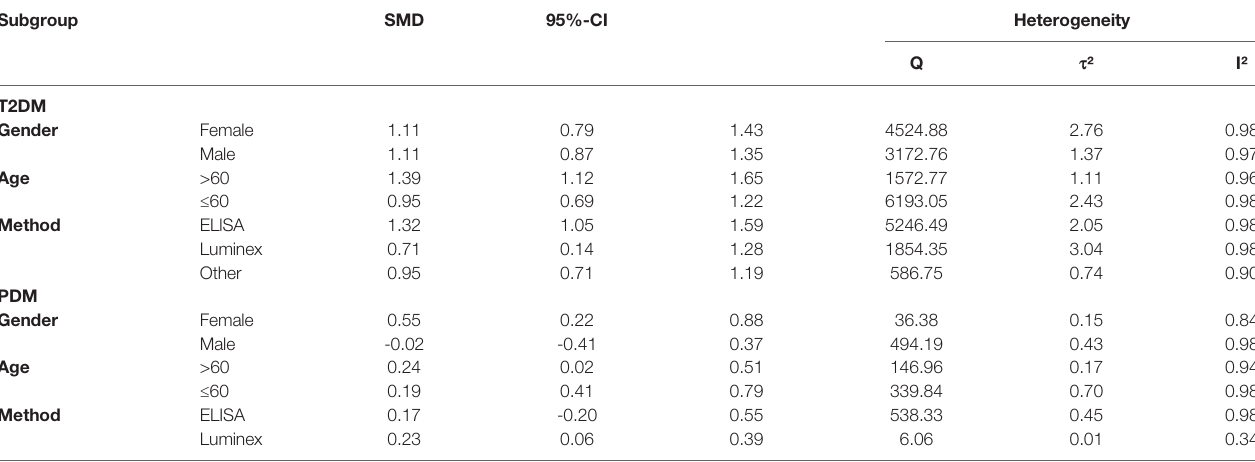
TABLE 3 | Subgroup analysis of chemokines between T2DM and PDM participants and controls. Subgroup